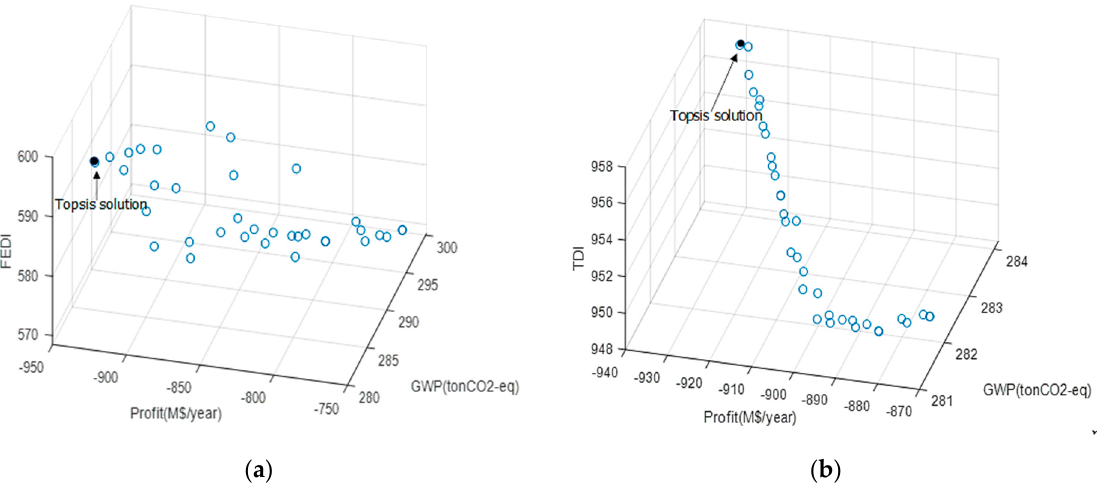
Figure 13. Pareto-optimal fronts for ( a ) profit, global warming potential, and fire explosion damage index and ( b ) profit, global warming potential, and toxicity damage index. Table 13. Decision variables that correspond to the selected Pareto-optimal solutions in Figure 13. Decision Variables